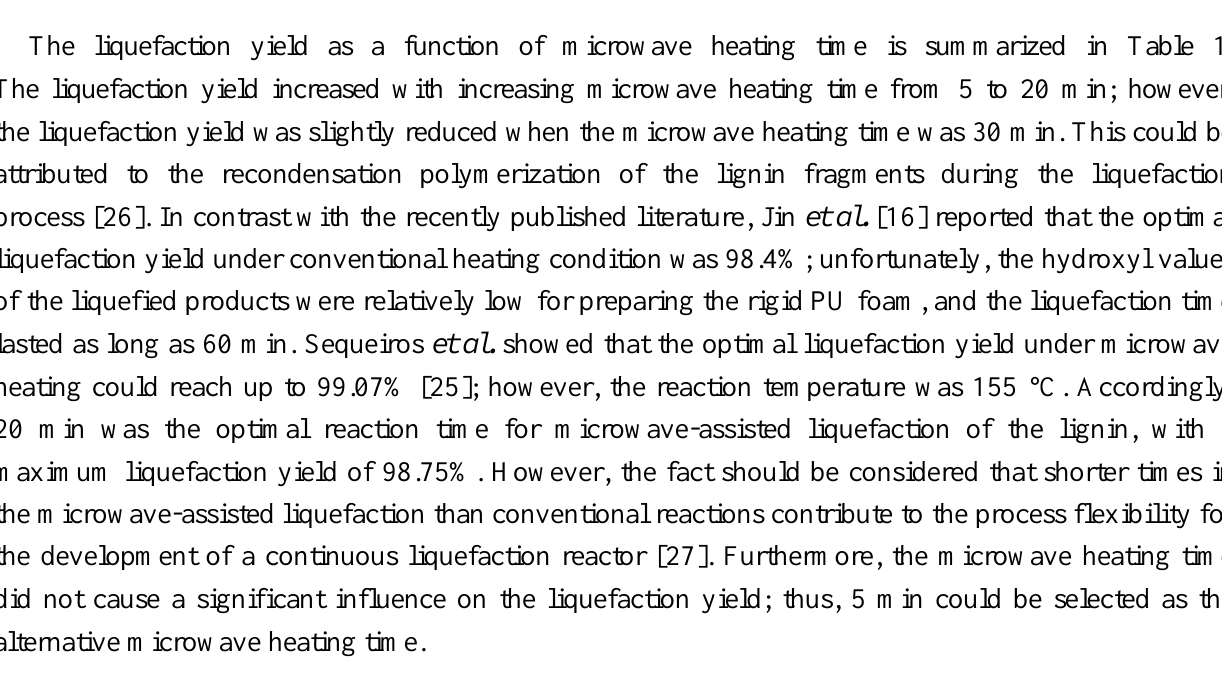
Table 1. Liquefaction conditions, yield and viscosities of the polyols. P,